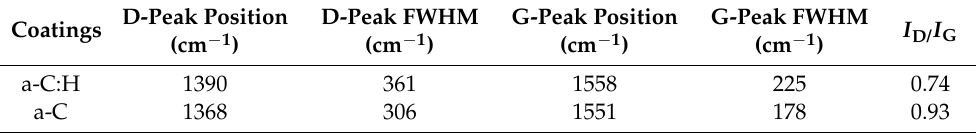
Table 1. Peak position and full width at half maximum (FWHM) of D and G peaks and the intensity ratio of the D and G peaks ( I D / I G ratio) for deposited